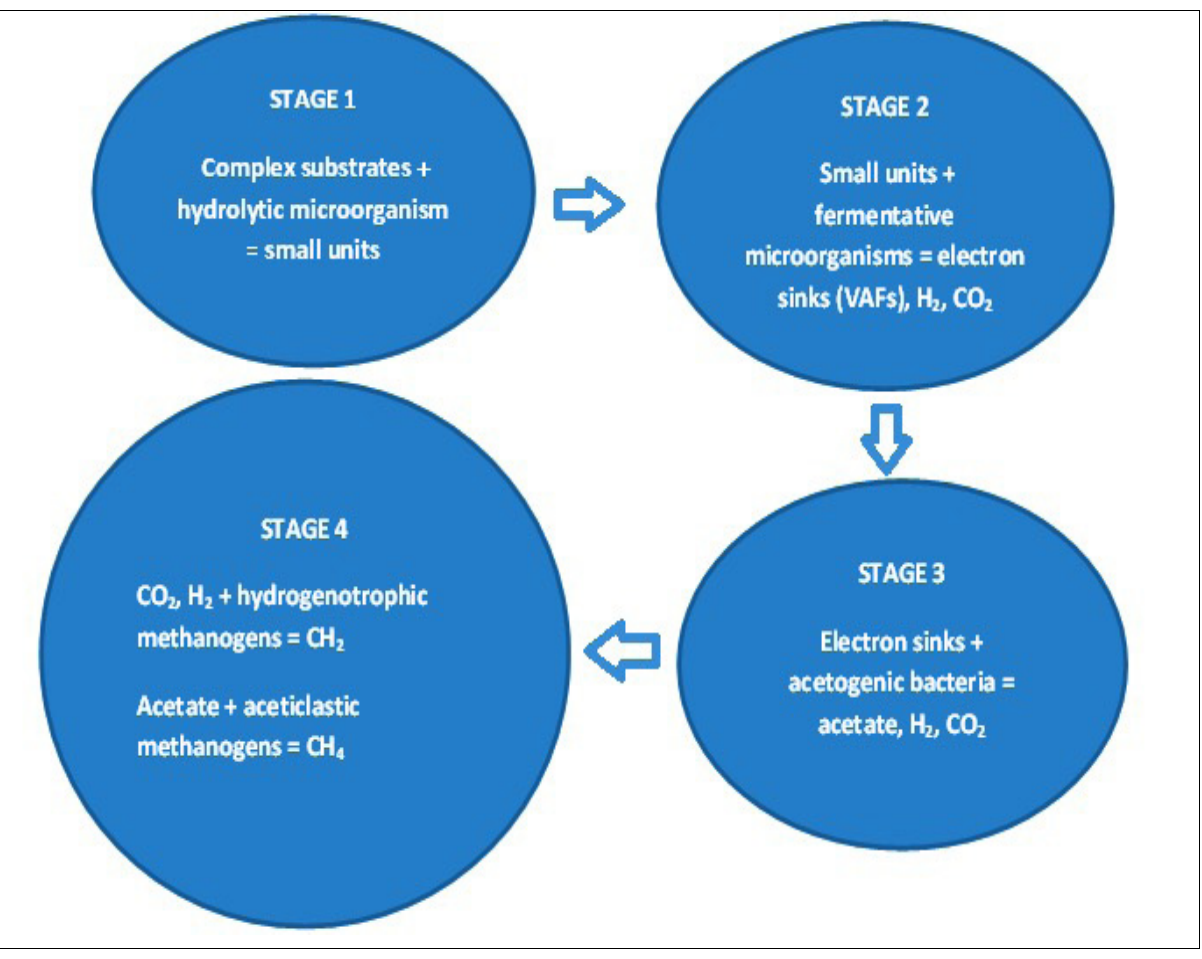
Figure 1: A schematic of the microbial processes involved in anaerobic